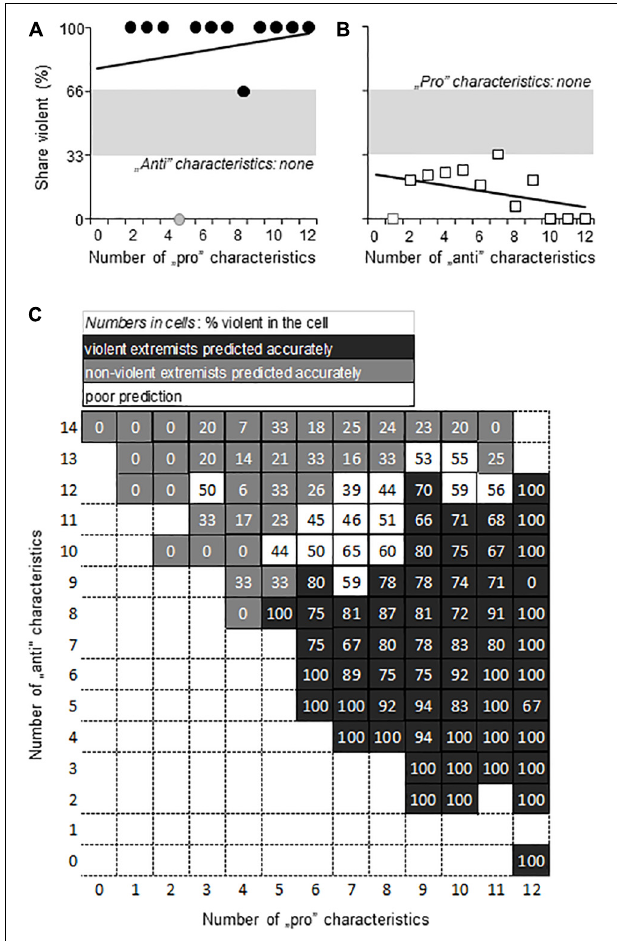
FIGURE 5 | Violence prediction by the number of pro- and anti-violence characteristics identified by machine learning. (A,B) When the opposite characteristic was not present, pro-violence (“pro”) and anti-violence (“anti”) characteristics predicted violence with high accuracy. Note that sample sizes were low; symbols in gray indicate N = 1 for the given “pro”/”anti” characteristic combination. (C) The interactive dependence of violence on the relation between the number of pro-violence and anti-violence characteristics present in the individual. Gray in panels (A–C) , the area of chance prediction (34–65%, i.e., close to